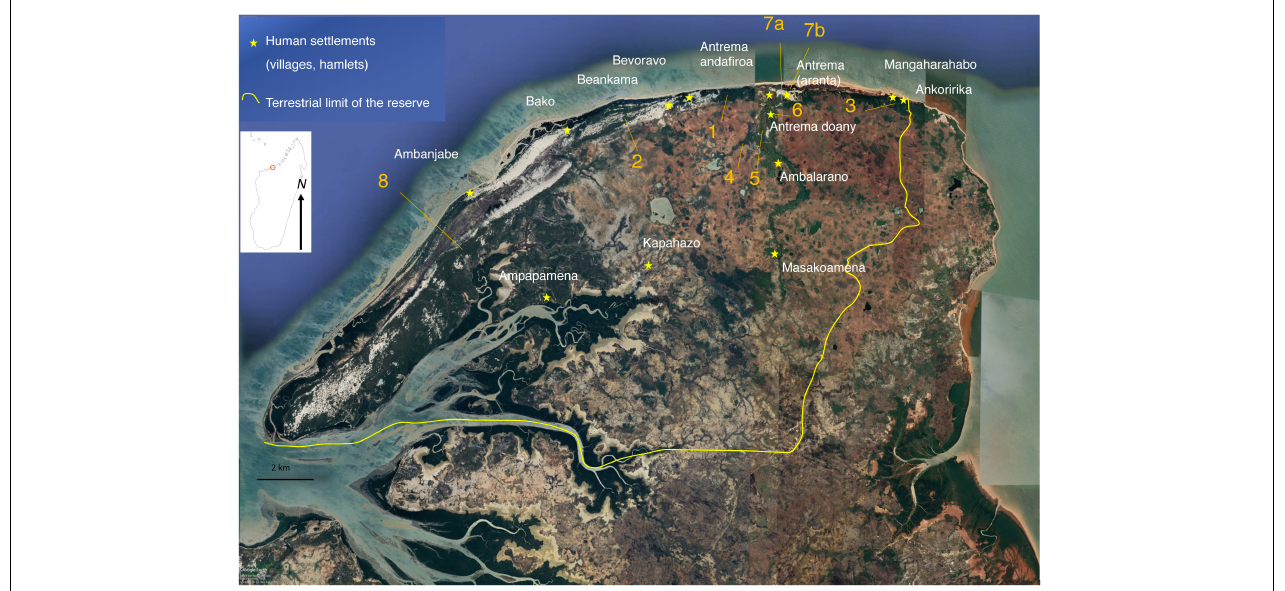
FIGURE 1 | Location of villages, lemur surveys and forest sites prospected in Antrema. The inset map shows Madagascar and the study area (open circle). Note that the following forest sites (identified and located by their number) are sometimes named after the nearest village: 1, Badrala; 2, Beankama/Bako;